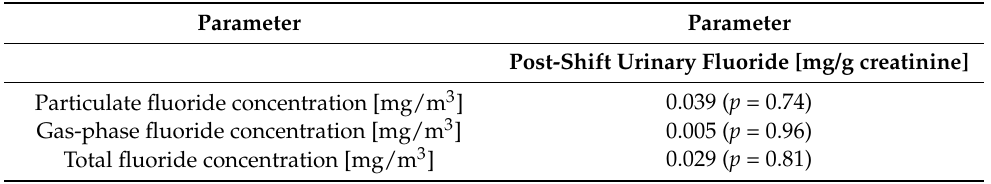
Figure 2. Comparison of urinary fluoride concentrations during the research period.